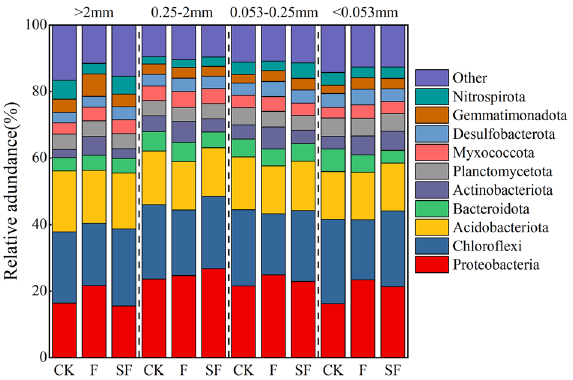
Figure 2. Relative abundance of phylum level for bacterial communities in different soil aggregates. The category “other” includes unclassified microbes and other less abundant